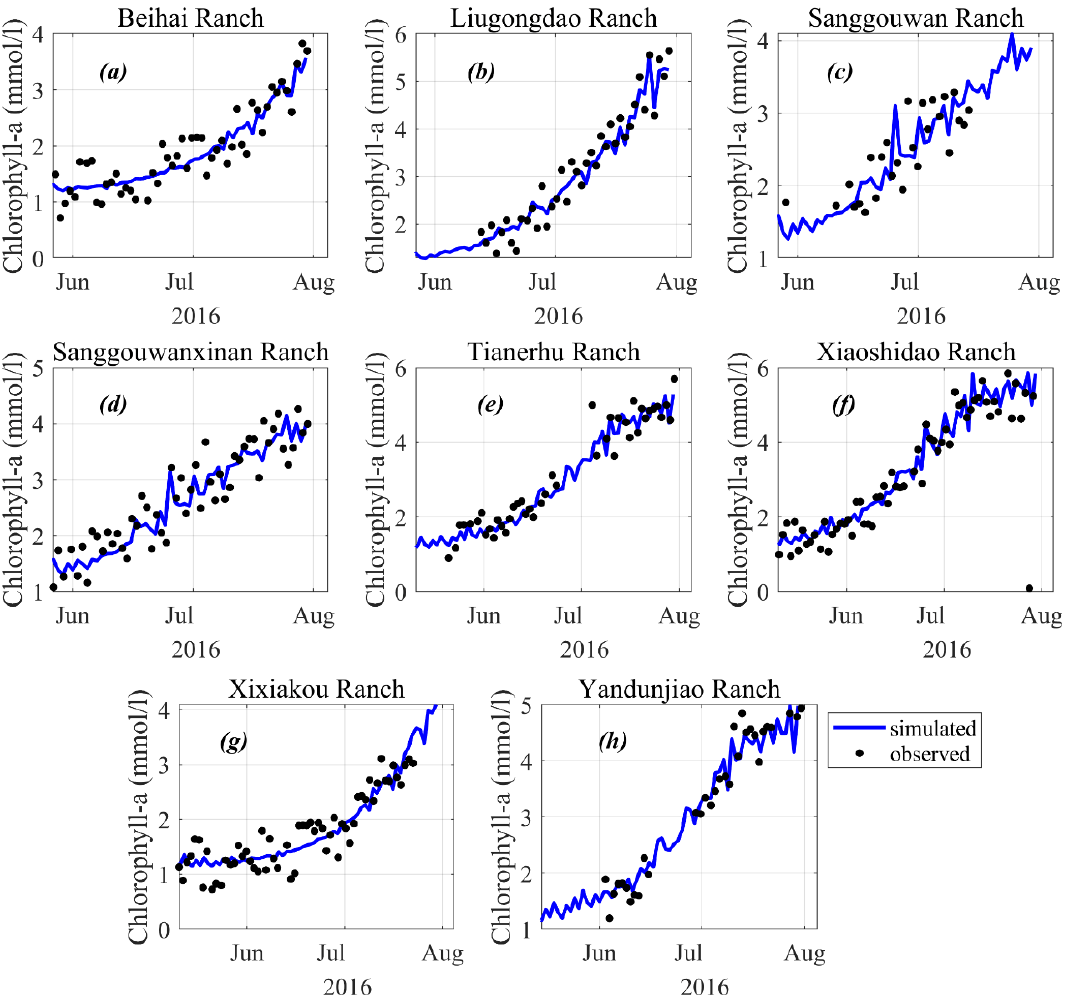
Figure 5. Comparison between simulated (blue solid lines) and observed (black dots) chlorophyll-a concentrations in different ranches. ( a – h ) are for Beihai Ranch, Liugongdao Ranch, Sanggouwan Ranch, Sanggouwanxinan Ranch, Tianerhu Ranch, Xiaoshidao Ranch, Xixiakou Ranch and Yandun- jiao Ranch, respectively. Table 2. The mean absolute error (MAE) between simulated and observed chlorophyll-a concentra- tion in different ranches.